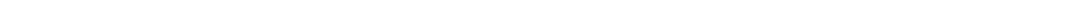
Fig. 3 Subanesthetic ketamine evokes sustained cortical disinhibition, which is reversed with NRG1 treatment. A Schematic depicting the medial prefrontal cortex (mPFC) region of mouse brain from which recordings were taken. B Schematic of recording inhibitory postsynaptic currents (IPSCs) in L2/3 pyramidal (PYR) neurons by preferentially activating L5 → L2/3 feedforward projections to L2/3 PV neurons through L5 electrical stimulation. Recorded pyramidal neurons are fi lled with biocytin for post-hoc morphological con fi rmation. C Ketamine acutely applied to cortical slice baths does not induce any change in inhibitory inputs to L2/3 pyramidal neurons ( n = 9 cells). Ketamine was washed into cortical slices at a bath concentration of 100 µM starting at 15 min before recording, and continuing through recording. D MK-801 in vivo treatment 24 h prior to recording does not induce any change in inhibitory inputs to L2/3 pyramidal neurons ( n = 9 cells). MK-801 is injected to animals at a concentration of 0.1 mg/ kg 24 h before recording. E However, ketamine in vivo treatment (10 mg/kg; s.c.) dramatically reduces evoked IPSCs to PYR neurons with acute and sustained long-term effects at 1 h ( n = 12 cells), 24 h ( n = 8 cells), 48 h ( n = 9 cells), 72 h ( n = 9 cells), and 1 week ( n = 9 cells) following treatment. Ketamine-evoked sustained decreases in IPSCs are acutely reversed with bath application of NRG1 (5 nM). F HNK in vivo treatment (10 mg/kg; s.c.) 24 h before recording, reduces synaptic inhibition to L2/3 pyramidal cells. Bath application of NRG1 (5 nM) then reverses the effect of in vivo HNK treatment and increases inhibitory inputs ( n = 8 cells) (Linear mixed effect model: overall, p = 2.09 × 10 − 5 ; NRG1 vs base p = 1.92 × 10 − 5 , NRG1 vs wash p = 5.3 × 10 − 5 ; mean ± SEM). G Summary data of average evoked IPSC amplitudes in L2/3 pyramidal neurons under the speci fi ed conditions (saline, 1, 24, 48, and 72 h, and 1 week after ketamine treatment) (One-way ANOVA: overall p = 1.77 × 10 − 20 . Two-sample t test (adjusted for multiple comparisons): in vivo ketamine vs saline, 1 h p = 5.01 × 10 − 9 , 24 h p = 8.54 × 10 − 8 , 48 h p = 1.69 × 10 − 8 , 72 h p = 1.04 × 10 − 8 , 1 week p = n.s.; mean ± SEM). H Acute NRG1 treatment increases average evoked IPSC amplitudes ratios in L2/3 pyramidal neurons under the speci fi ed conditions (control saline, 1, 24, 48, and 72 h, and 1 week after ketamine treatment) (One-way ANOVA: overall p = 2.4 × 10 − 8 . Two-sample t test (adjusted for multiple For each trial, electrical stimulation (1 ms, 20 µA) was applied, represented by a black tick beneath one example trace. For the example trace, the arrow indicates the current injection response to monitor access resistance during the